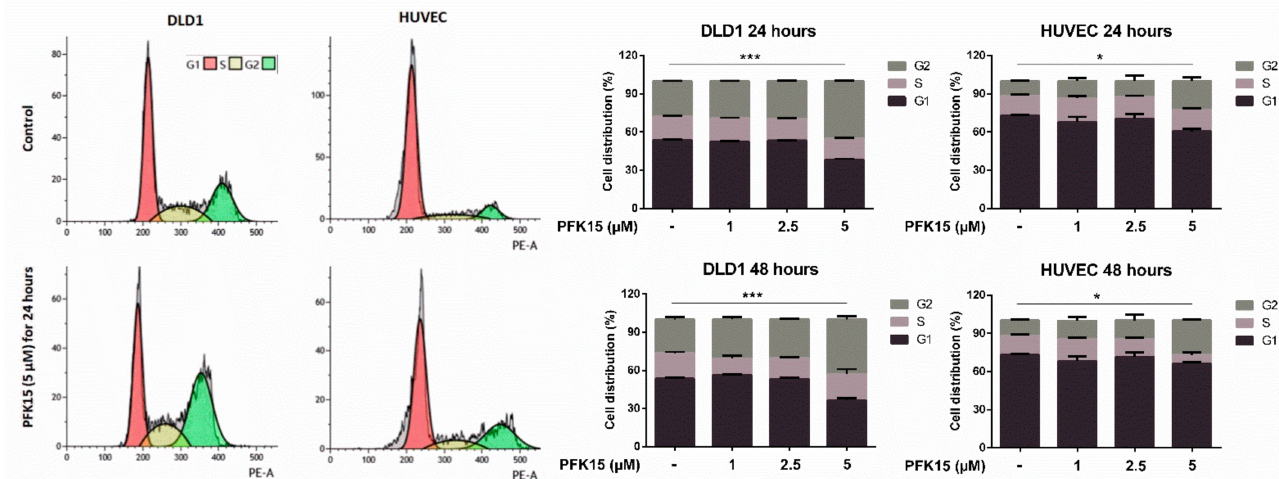
Figure 5. PFK15 induced arrest in the G2 phase of the cell cycle. Cells were cultured in the presence of PFK15 for 24 and 48 h. DNA was stained by propidium iodide and analyzed by flow cytometry. Left panel: representative pictures of cell cycle analysis. Right panel: results are presented as mean of triplicates ± SEM. One out of three independent experiments is presented. * p < 0.05, *** p < 0.001.